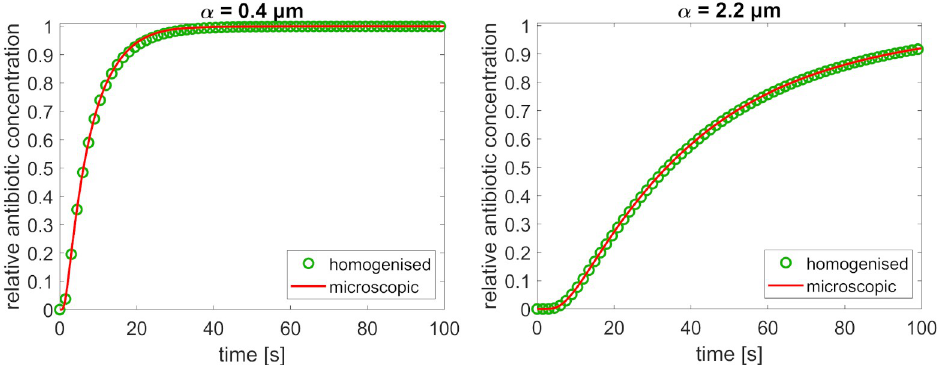
Fig 3. The antibiotic concentration at the bacterium boundary over time, as a fraction of the equilibrium concentration, with a comparison of the microscopic and homogenised model. The results are shown for two degrees of adsorption, quantified by the binding equilibrium constants α . The number of phage layers in both graphs is N = 83, corresponding to a tactoid thickness of 1 μ m and an interphage distance of 6 nm.